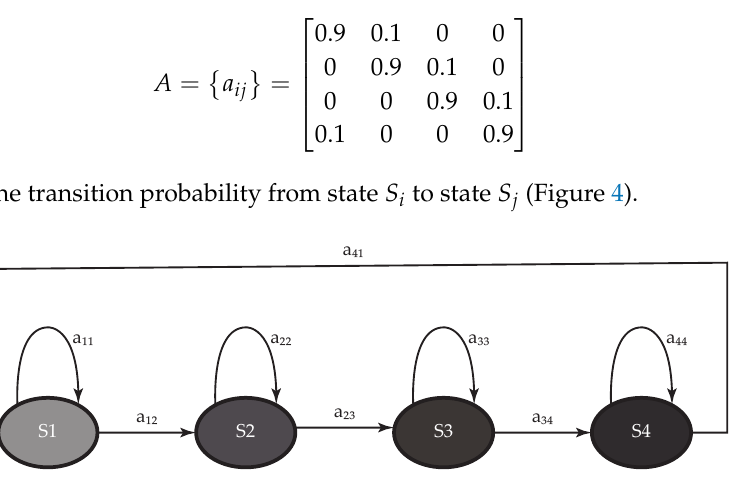
Figure 4. Possible transitions ( a ij ) among four states ( S i ) of a continuous HMM according to a left–right model. Each model state is paired to a gait phase, whose emissions are modeled using a Gaussian mixture model with three components. a ij denotes the transition probability from state S i to state S j